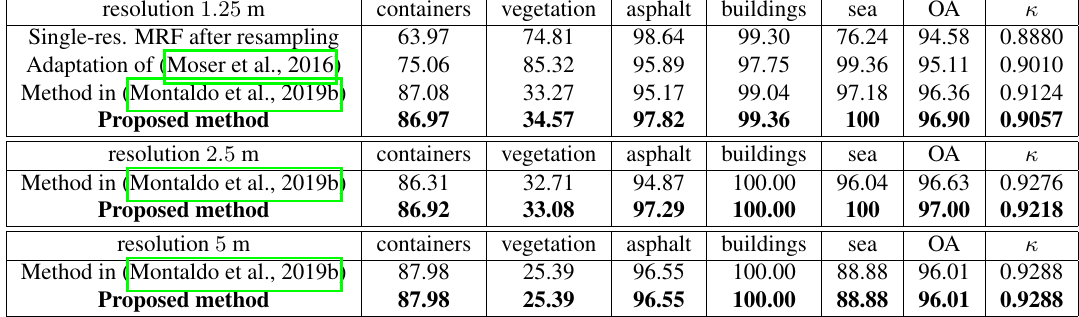
Table 2. “Alessandria” data set. Overall accuracy (OA) [ % ], Cohen’s κ , and class-by-class accuracies [ % ] on the test set for the proposed algorithm and the compared benchmark